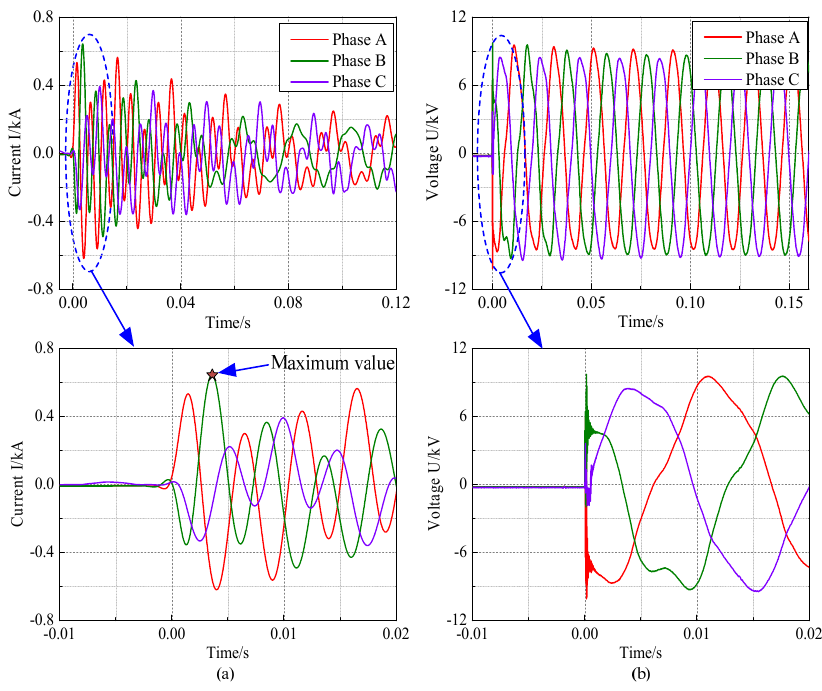
Figure 8. Waveforms of the closing current and capacitor voltage in Case 1. ( a ) Current waveform; and ( b ) voltage waveform.